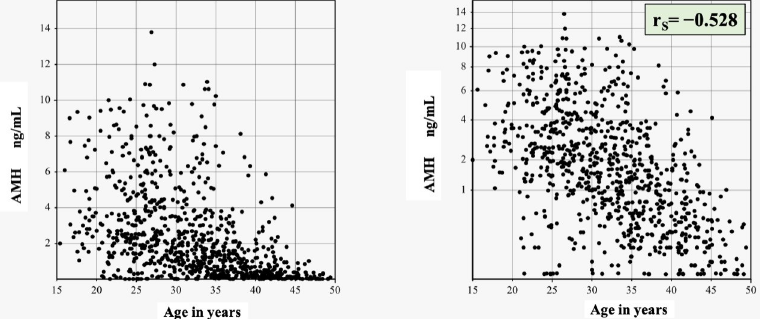
Fig 4. Scatterplot of AMH versus age without (left) / with adjustment of the scale of AMH axis to fit the AMH power transformation